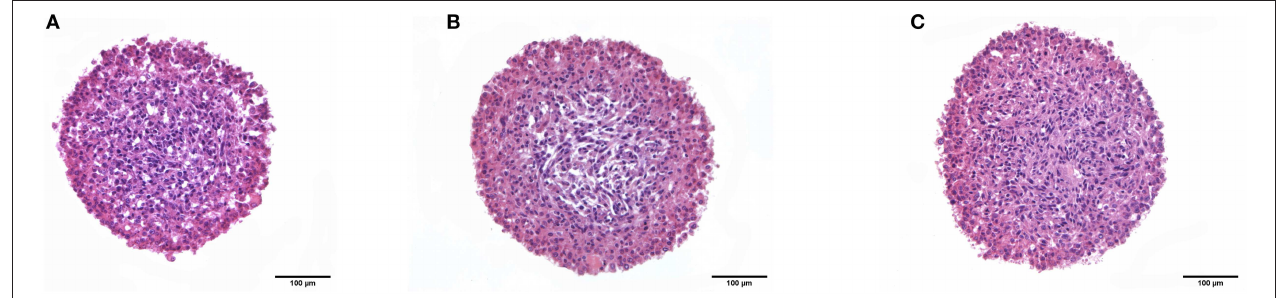
FIGURE 6 | Histological images of spheroids embedded in hydrogel at days 1 (A) , 3 (B) , and 6 (C)